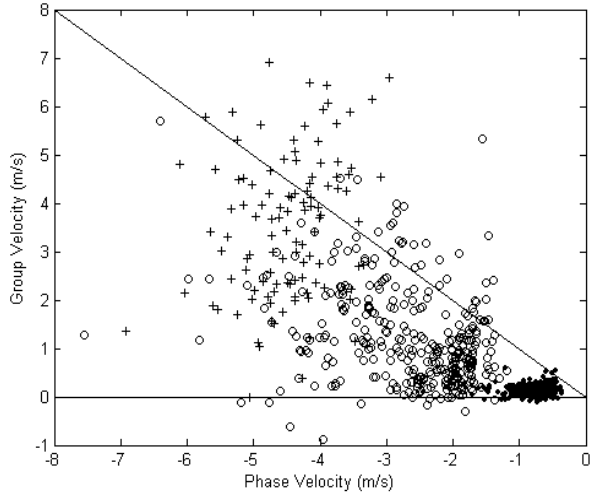
Fig. 12. Scattering plot of vertical phase velocity vs. vertical group velocity of the sampled wave packets. Dot: denote the wave packets sampled by the window T2Z1; open circle: sampled by windows T2Z3 and T2Z4; cross: sampled by window T2Z5. The solid lines are reference lines for v gz = 0 and v gz =− v pz , respectively.